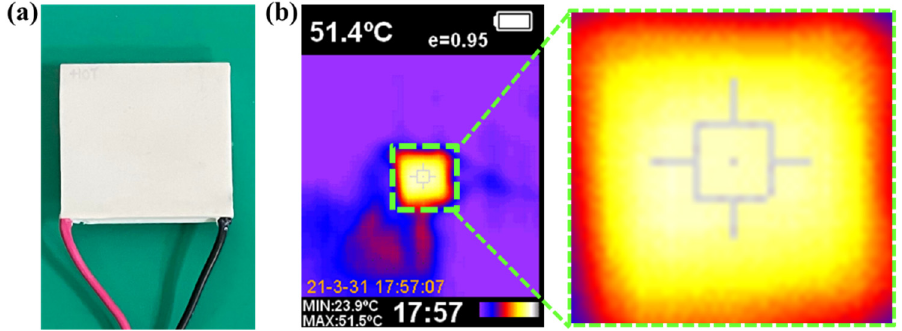
Figure 3. ( a ) Photo of TEC without operating and ( b ) temperature uniformity of TEC hot surface.